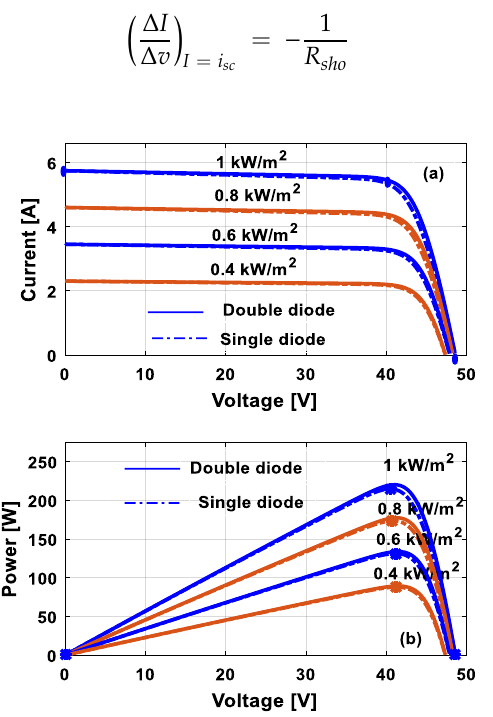
Figure 4. PV system: ( a ) I-V and ( b ) P-V characteristics at different irradiation conditions.